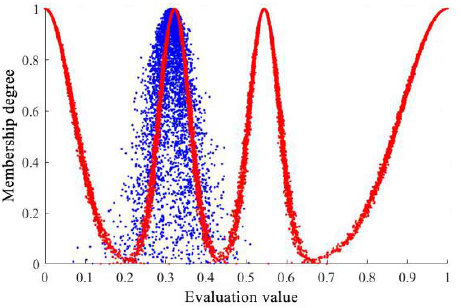
Figure 6. Cloud pictures of comprehensive risk evaluation indexes in criterion level: ( a ) Support conditions; ( b ) Roof con- ditions; ( c ) Personnel working status; ( d ) Coal body status.